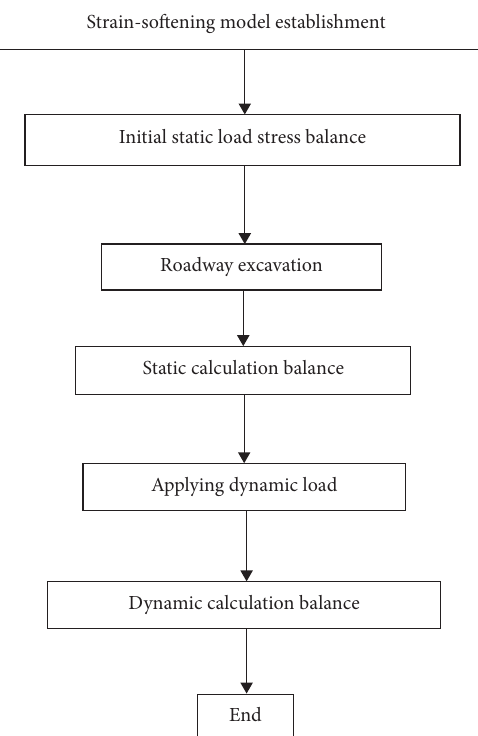
Figure 5: Flow chart of the numerical simulation. Table 2: Simulation support design